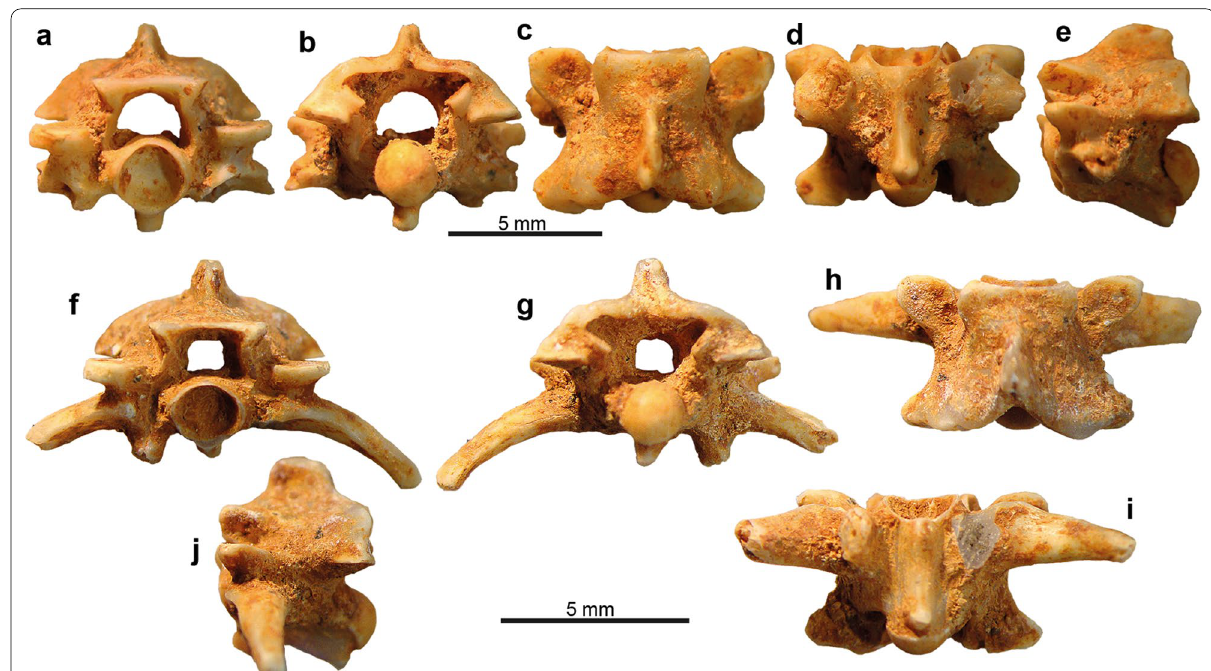
Fig. 94 Phosphoroboa filholii comb. nov. from the late Eocene of Escamps C, Phosphorites du Quercy: a – e anterior cloacal vertebra (UM ECC 3095) in anterior ( a ), posterior ( b ), dorsal ( c ), ventral ( d ), and left lateral ( e ) views; f – j cloacal vertebra (UM ECC 3096), more posterior than the previous one, in anterior ( f ), posterior ( g ), dorsal ( h ), ventral ( i ), and left lateral ( j )